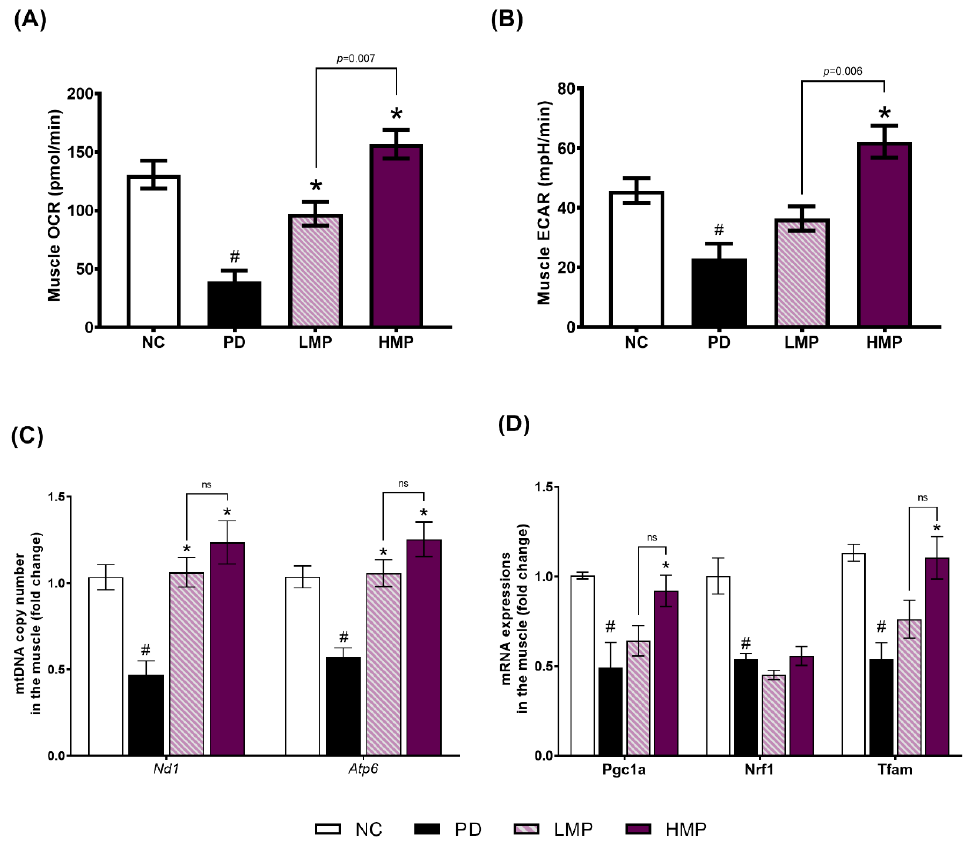
Figure 5. Comparison of mitochondrial function and mitochondria-related mRNA expression in muscles after 8 weeks of supplementation in the rat model of PD. ( A ) The basal oxygen consumption rate (OCR) was quantified to evaluate mitochondrial respiration. ( B ) Basal extracellular acidification flux (ECAR) was used to evaluate the rate of glycolysis. ( C ) mtDNA copy numbers ( Nd1 and Atp6 ). ( D ) Expression of mitochondrial biogenesis-related mRNAs: PPARG coactivator 1 alpha ( Pgc1a ), nuclear respiratory factor 1 ( Nrf1 ), mitochondrial transcription factor A ( Tfam ). Results are average ± SEM for n = 5 rats/group and were analyzed using one-way ANOVA with Tukey’s post hoc test. # p < 0.05 for the Parkinson’s disease (PD) group vs. the normal control (NC) group. * p < 0.05 for the low-dose mangosteen pericarp (LMP) and high-dose mangosteen pericarp (HMP) groups vs. the PD group. ns, not